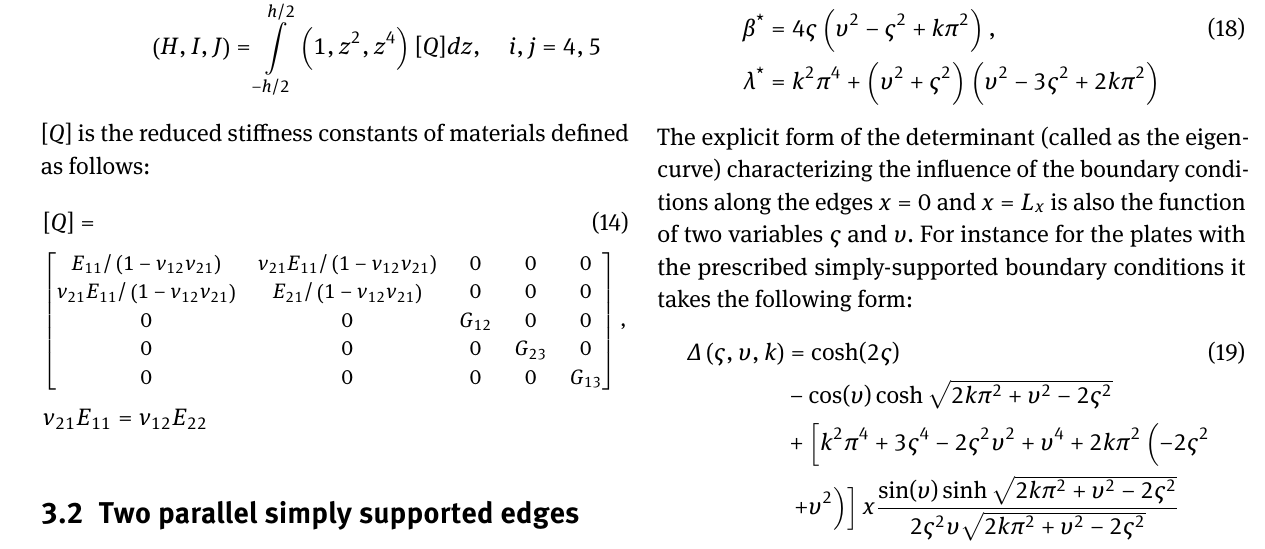
In the plane ς and υ it is possible to plot the determinant and the parameters λ * (proportional to the eigenfrequency) and β * (proportional to the aerodynamic pressure) – see Figure 4. The critical point corresponding to the flutter phe- nomena is described as the single point arising as the tan- gent between the trajectories of the determinat and of the curve β * . The value of the critical aerrodynamic pressure crit is defined by the value λ * cutting the critical point. To crit identify the influence of the material distribution on the value of the critical aerodynamic pressures it is necessary to analyse the inluence of three parameters k , λ * and β * on the position of the critical point drawn in Figure 4.